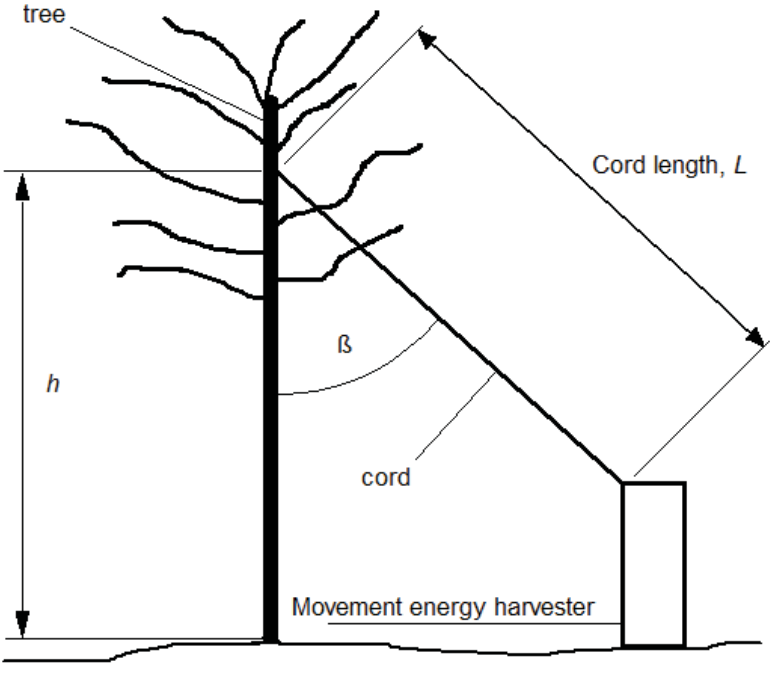
Figure 4. Side view sketch of tree and movement energy harvesting